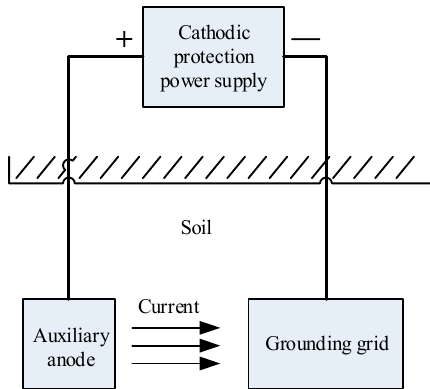
Figure 1. Grounding grid cathodic protection model.